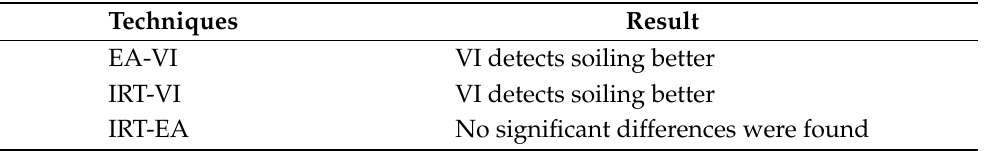
Table 10. Significant differences in the detection of each type of failure between the methods studied. Note: The types of failures not indicated had no significant